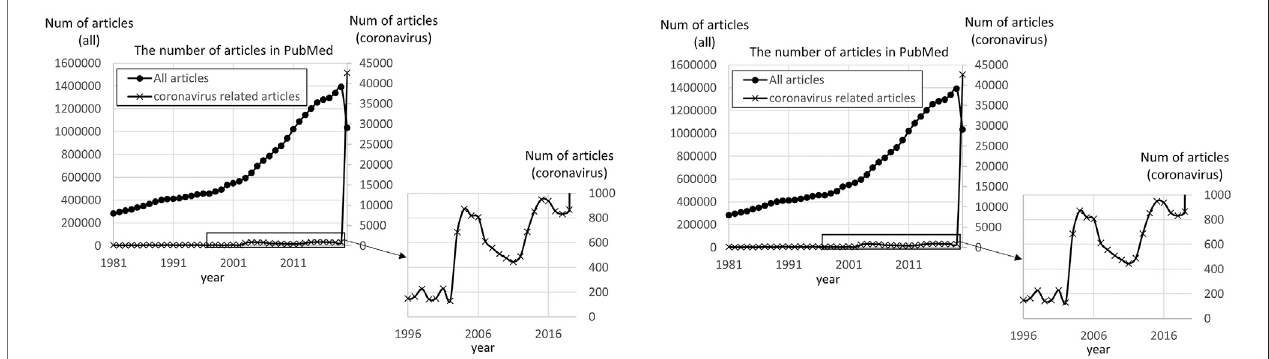
FIGURE 1 | Number of articles on coronaviruses published in PubMed. The number of articles was counted on Aug 17th, 2020. “ All articles ” represents the total number of articles found in PubMed as published in each year (the scale is shown in the left x axis). “ Coronavirus-related articles ” represents the total number of articles found by the query of “ coronavirus OR COVID-19 OR SARS-CoV OR MERS-CoV ” (the scale is shown in the right x axis).